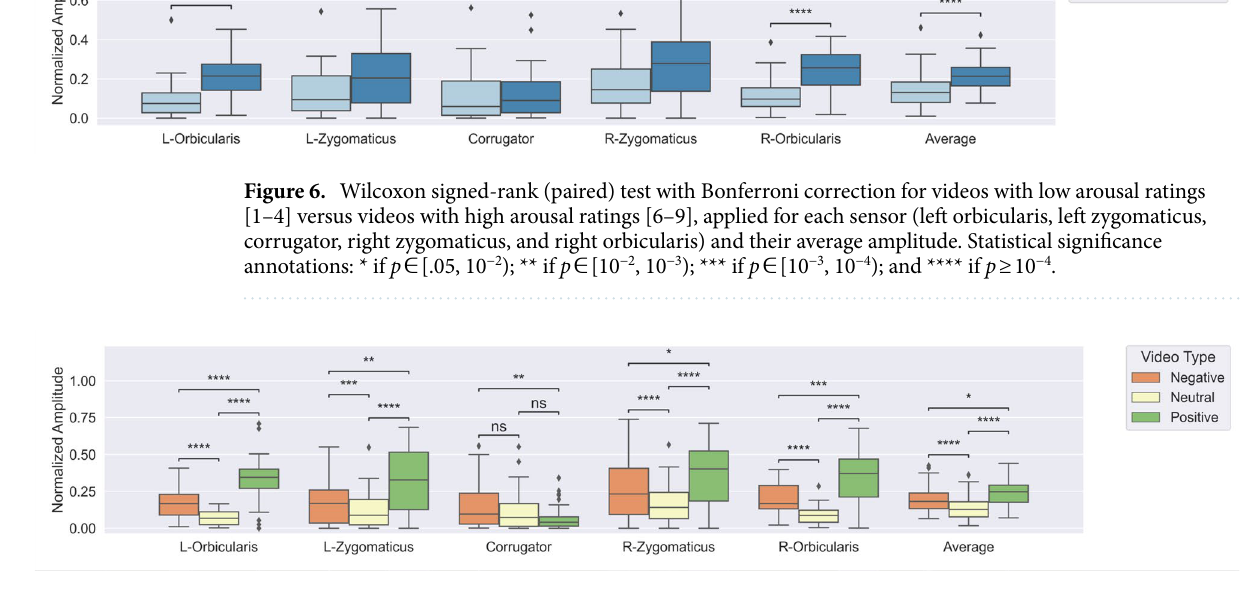
Figure 7. Wilcoxon signed-rank (paired) test with FWE corrected for each sensor (left orbicularis, left zygomaticus, corrugator, right zygomaticus, and right orbicularis) and their average amplitude for comparing: neutral versus positive, neutral versus negative and positive versus negative videos. Statistical significance annotations: * if p ∈ [.05, 10 −2 ); ** if p ∈ [10 −2 , 10 −3 ); *** if p ∈ [10 −3 , 10 −4 ); and **** if p ≥ 10 −4